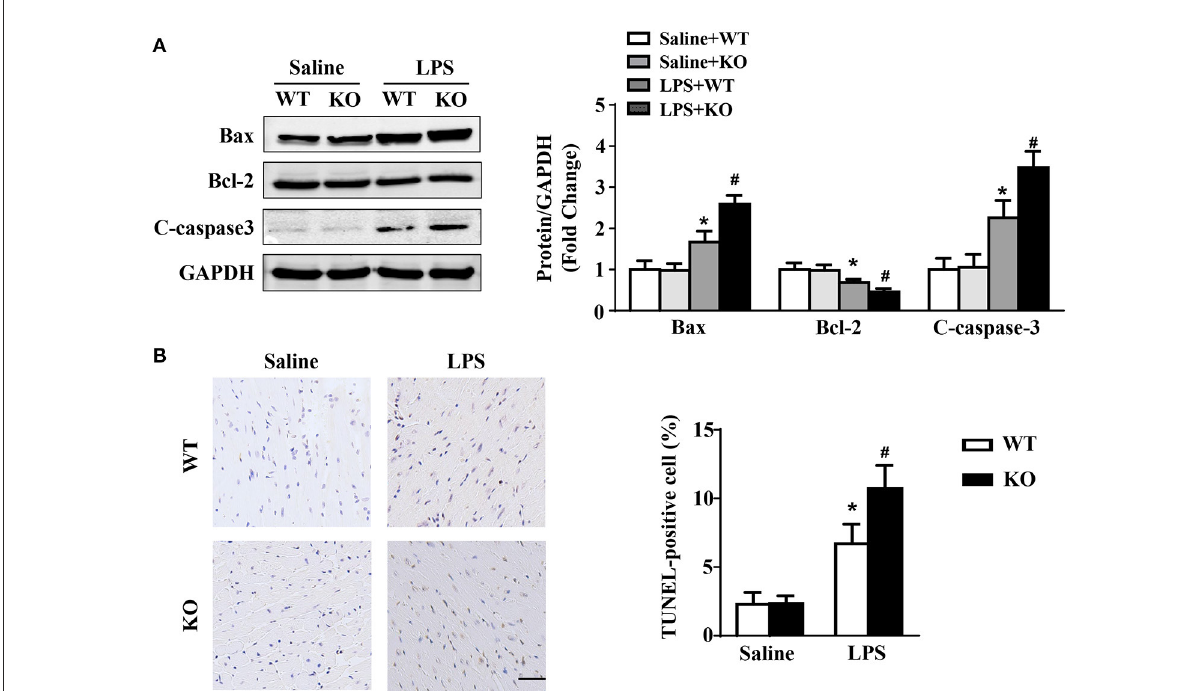
FIGURE5 IL-12p40 deletion aggravates LPS-induced myocardial apoptosis. (A) Western blot analysis of Bax, Bcl-2 and C-caspase-3 protein levels in heart tissues of each group ( n = 5). (B) TUNEL staining and the quantitative results of heart tissues in each group ( n = 6; scale bar, 50 µ m). * P < 0.05 compared with the Saline group. # P < 0.05 compared with the LPS + WT